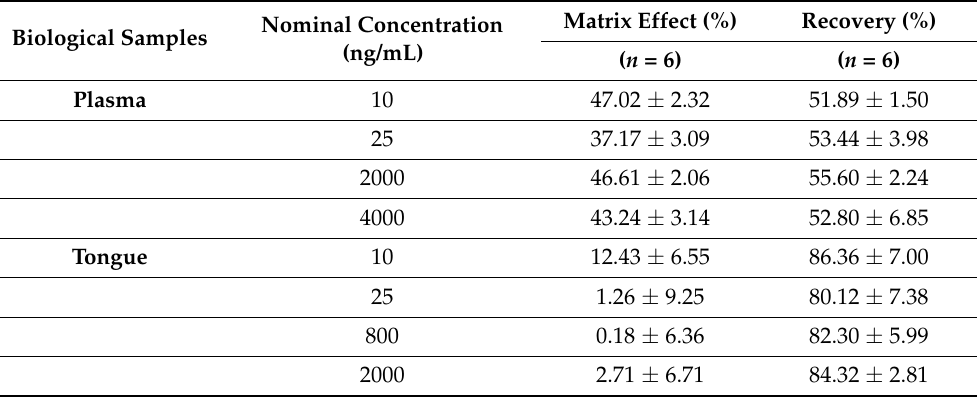
Table 2. Recovery and matrix effect of OXP in rat plasma and tongue homogenates quality control (QC) samples.